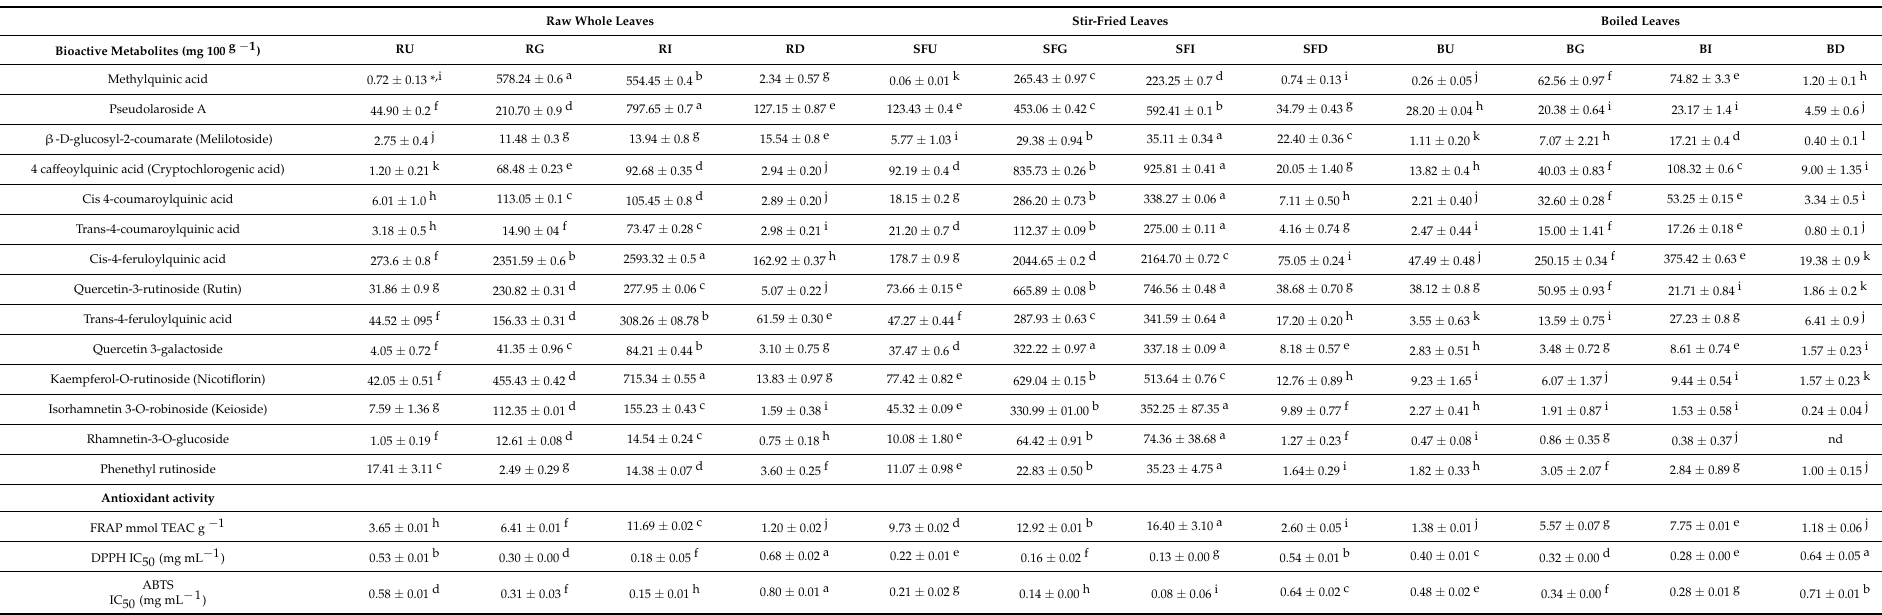
Table 1. The influence of stir-frying and boiling household cooking methods on bioactive metabolites and antioxidant activity after in vitro gastrointestinal digestion of African pumpkin leaves ( Momordica balsamina L.) compared to whole raw leaves. RawWholeLeaves Stir-FriedLeaves